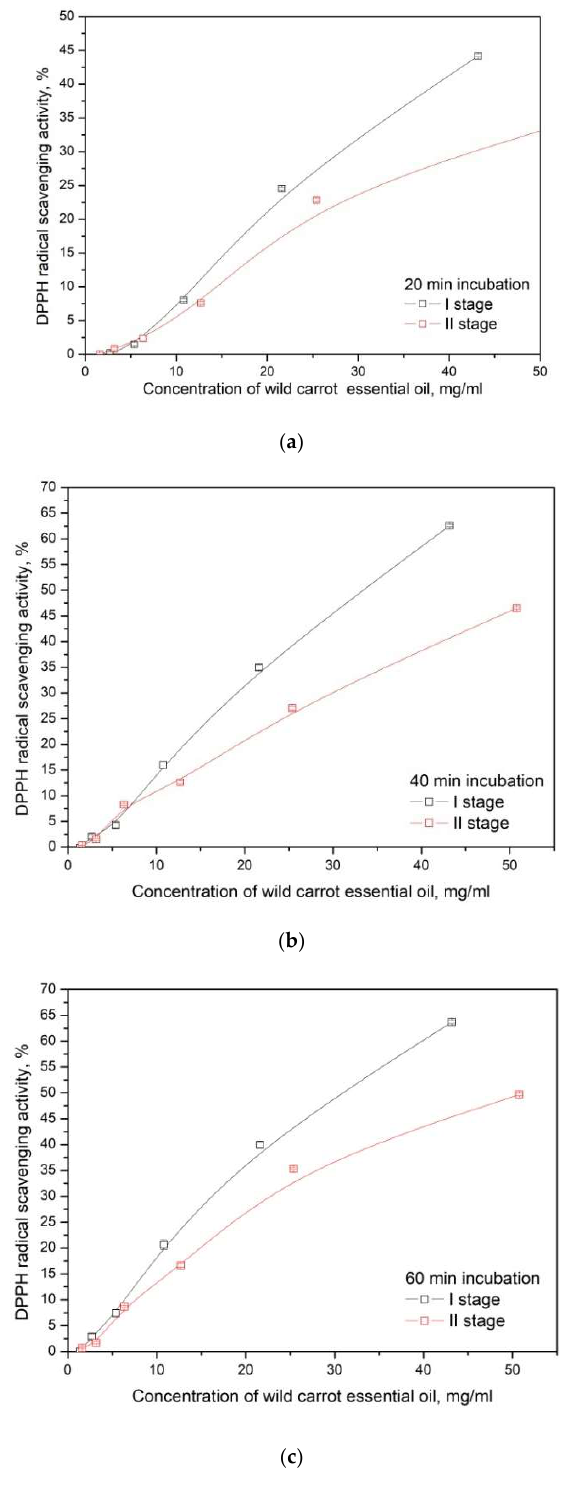
Figure 4. The capacity of DPPH radical neutralization by the wild carrot umbels’ essential oil